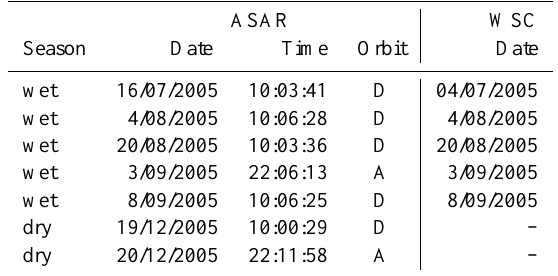
Table 2. Dates, time and orbit passes (Descending (D) or Ascending (A)) of radar image used in this